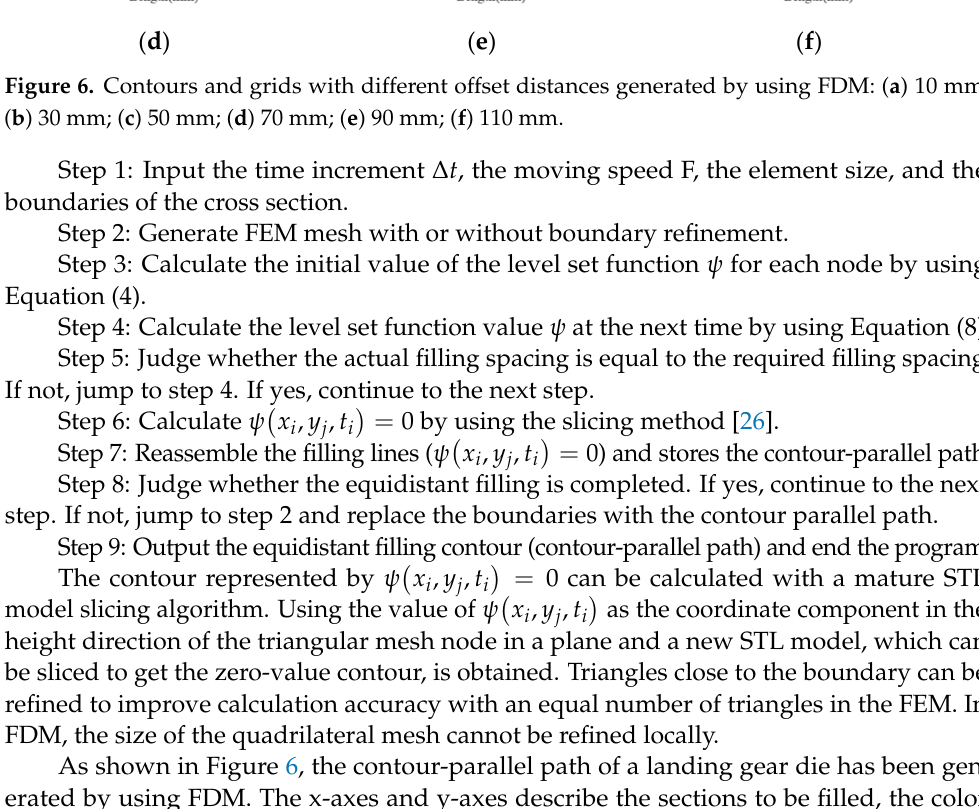
( f ) Figure 7. Contours and mesh with different offset distances generated by using FEM: ( a ) 10 mm; ( b ) 30 mm; ( c ) 50 mm; ( d ) 70 mm; ( e ) 90 mm; ( f ) 110 mm. The comparison of the path generation processes of FEM and FDM (Figures 6 and 7) shows that FEM can significantly reduce the calculation time. There are two reasons why the FEM algorithm is faster than the FDM algorithm. First, the solution domain of FEM can be greatly reduced with an increase in the number of offsets (only in the filled area), while the solution domain of FDM does not decrease with an increase in the number of offsets (in the largest rectangular area of the entire cross-section). Second, the mesh of the